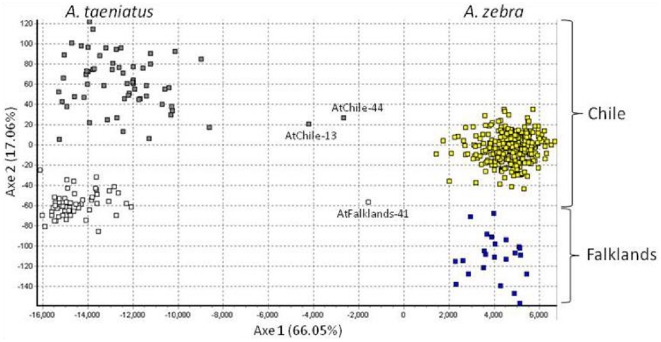
Species discrimination and identification of hybrids based on Principal Component Analysis of Aplochiton taeniatus and Aplochiton zebra microsatellite genotypes.PC1 and PC2 represent the first two factorial components. Three putative F1 hybrids are indicated by their ID sample codes.